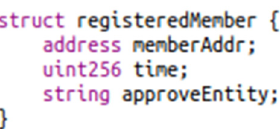
Figure 4. Member non-sensitive information is stored in the blockchain block (on-chain); sensitive information is stored on the content-addressing IPFS file-system and accessed only by authorized admin members.